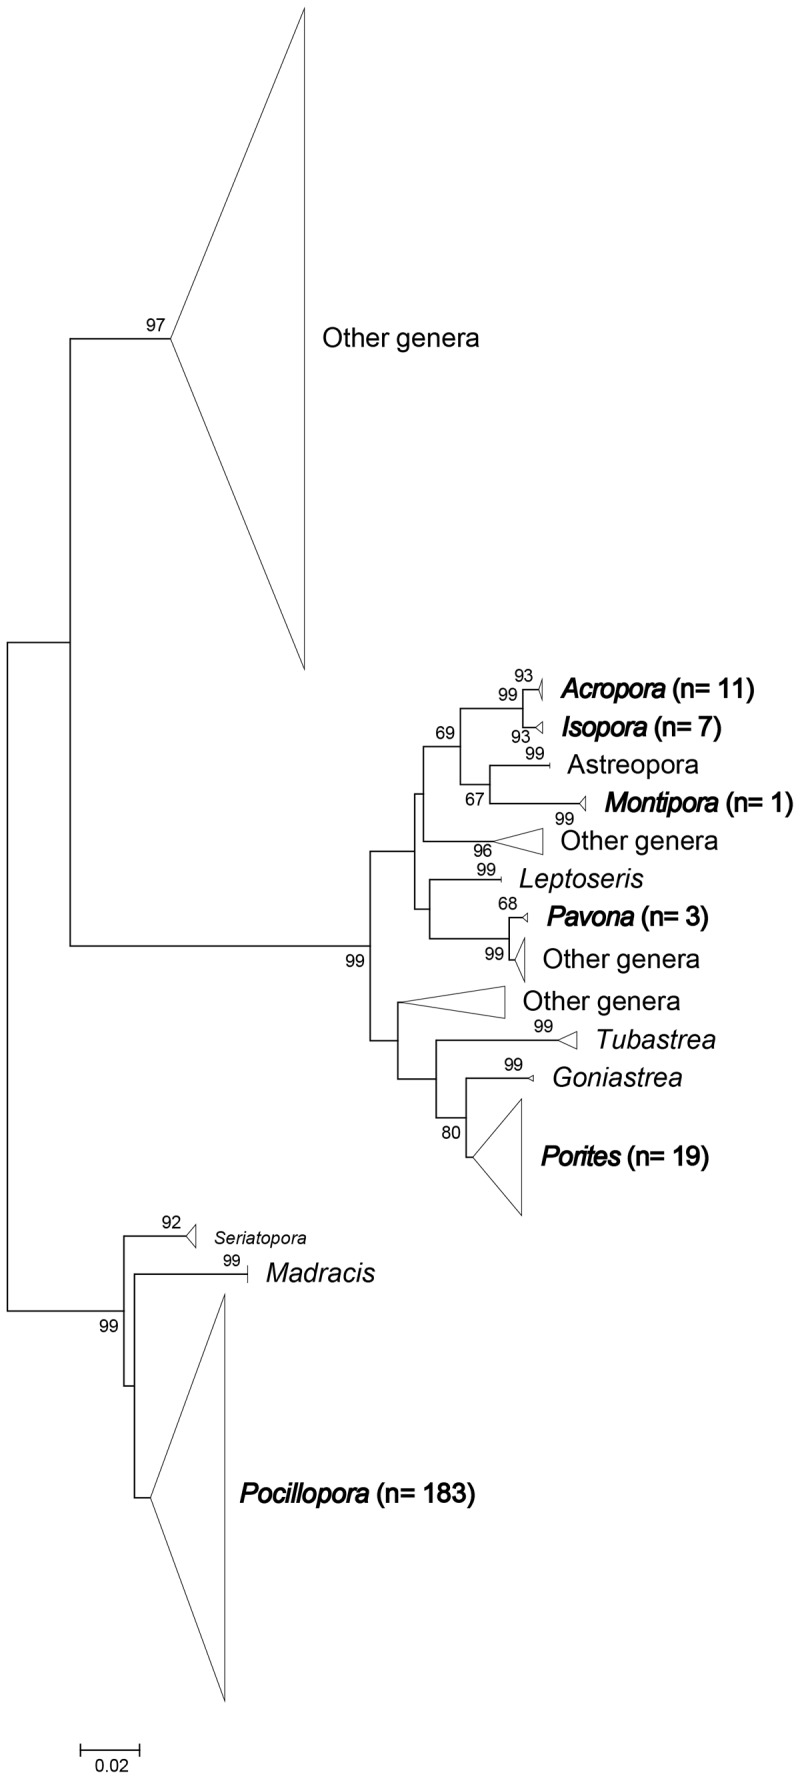
NJ tree of scleractinian COI sequences.Neighbor-joining tree of mitochondrial COI sequence constructed by Tamura three-parameter model with 1000 bootstrap replications. The genus with its sample number in parentheses labeled in bold was discovered from a settlement plate in this study. All other generic sequences were obtained from the database of the Barcode of Life (www.barcodeoflife.org).